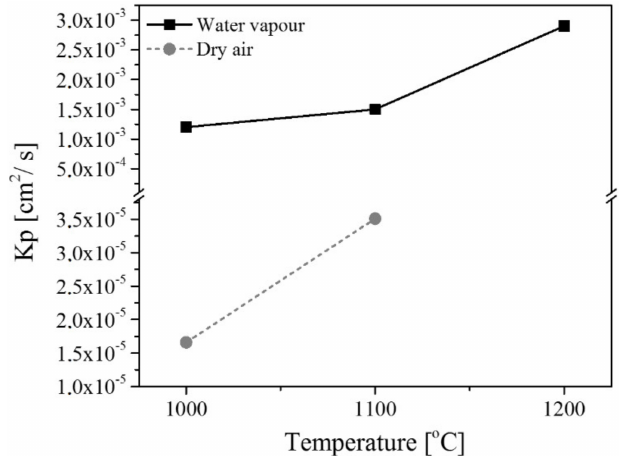
Figure 13. Parabolic oxidation rate ( k p ) as a function of